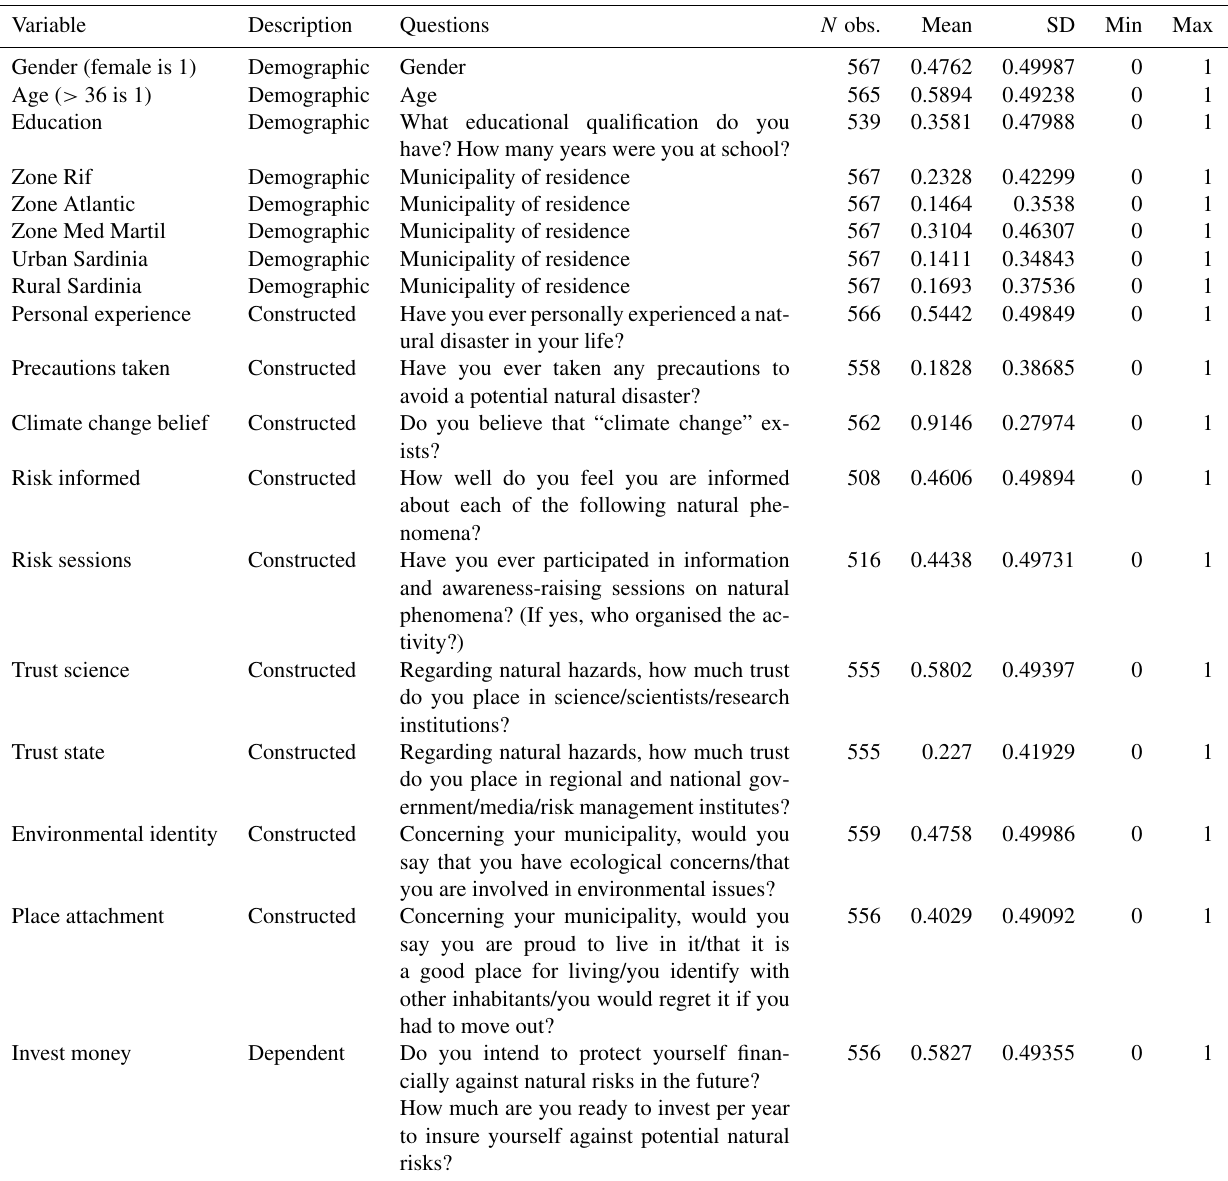
Table 1. Variables used in the regression model.